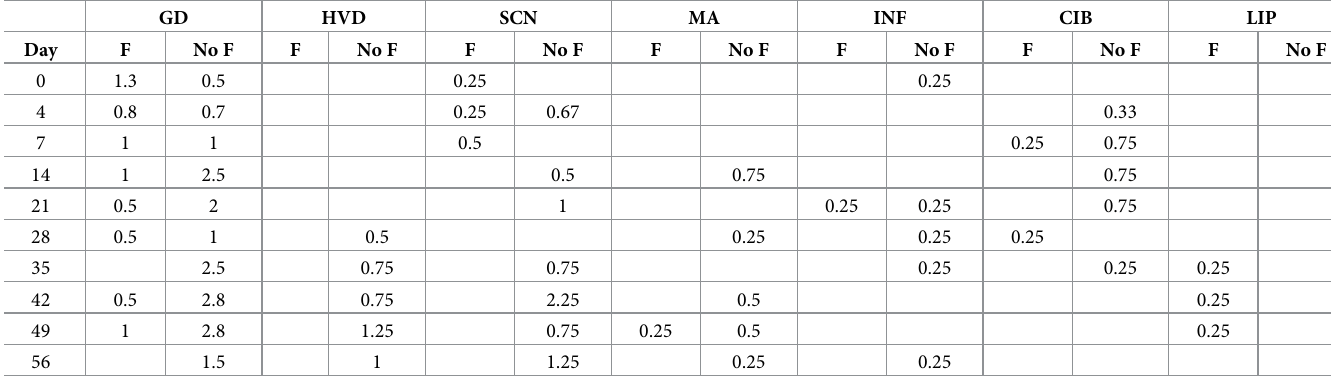
Table 2. Mean liver histological results from the experiment. GD HVD SCN MA INF CIB